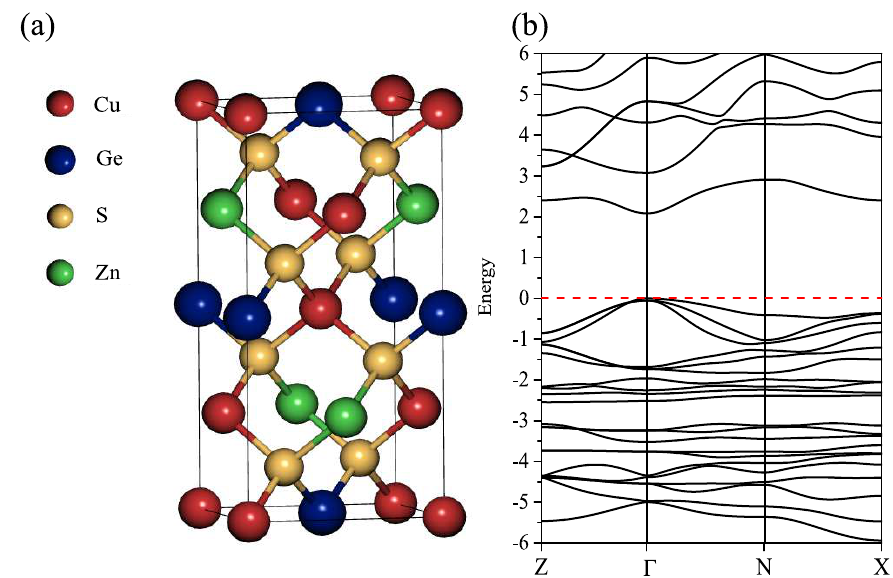
Figure 1. ( a ) The kesterite crystal structure; and ( b ) the calculated DFT-mBJ + U electronic band structure of kesterite Cu 2 ZnGeS 4